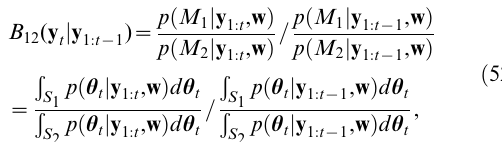
ƒ 0 . The lower-order log-linear parameters have again S 2 : h t 123 real